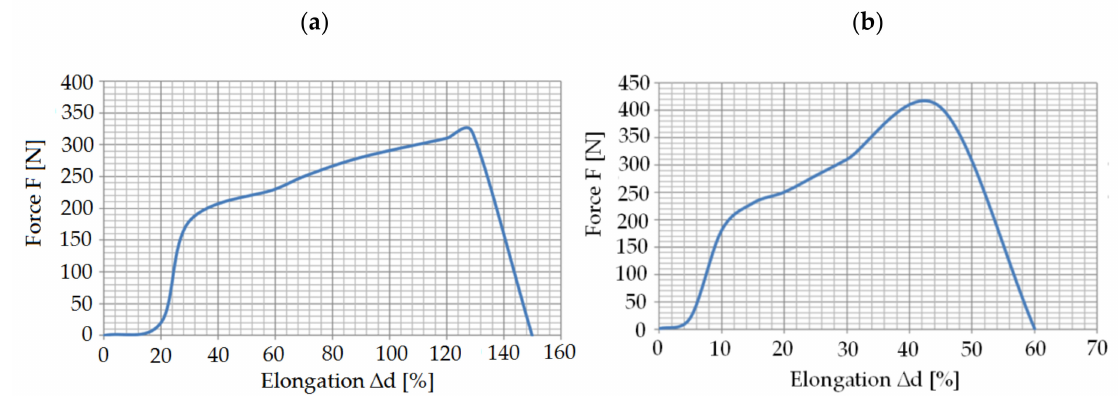
Figure 3. Graph of changes in tensile force as a function of elongation for a foil sample with a thickness of: ( a ) t = 80 µ m, ( b ) t = 60 µ